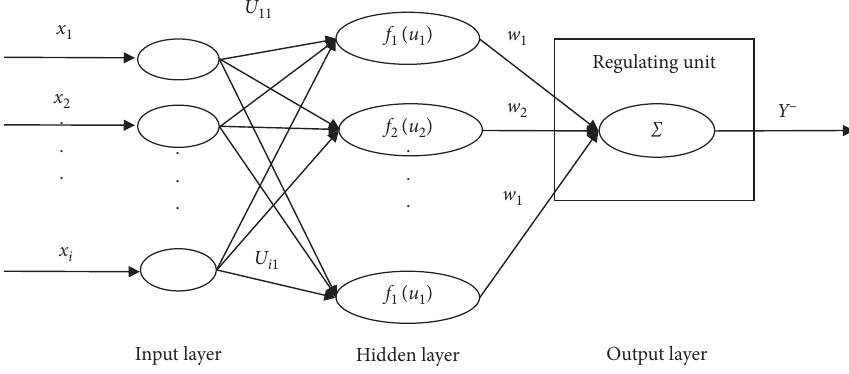
Figure 3: Pattern recognition